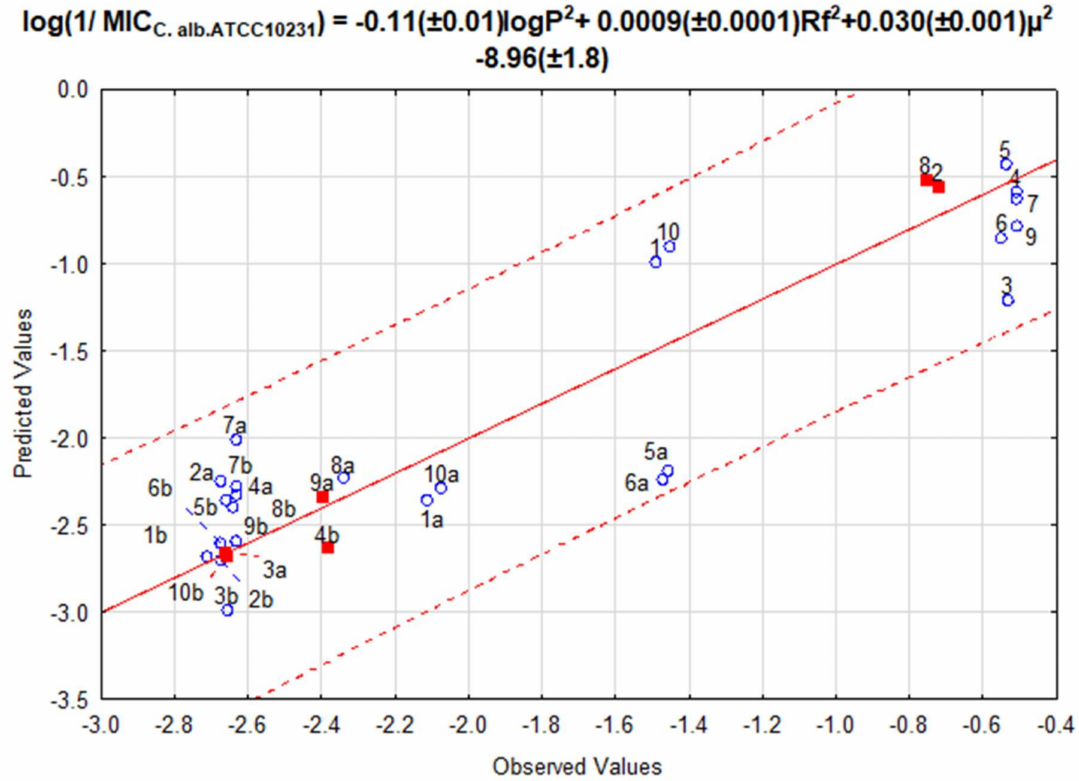
Figure 2. Correlation of activity against Candida albicans ATCC 10231 and logP 2 , RF 2 , µ 2 . Dashed lines mark the area of predictability of the received models, which are described by the equations featured (cid:4) above the graphs. —test set, ◦ —training